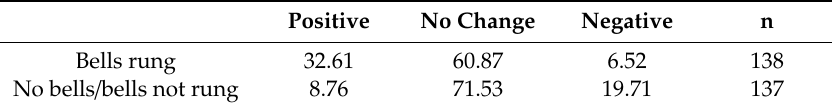
Table 6. Changes in attitude towards church bell-ringing activity (in